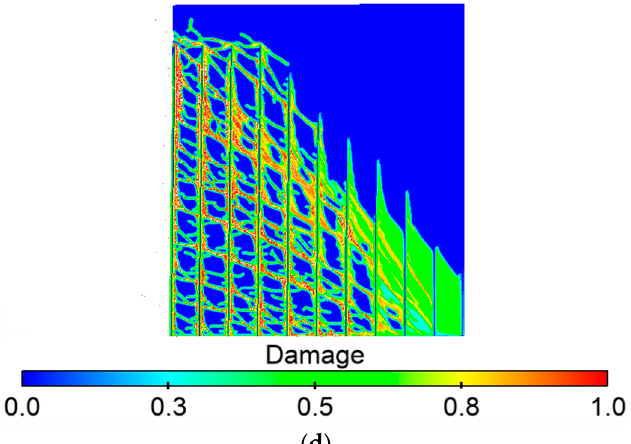
Figure 6. RC shear walls unilateral force damage process. ( a ) Initial stage; ( b ) Crack initiation; ( c ) Crack propagation and ( d ) Structure failure.